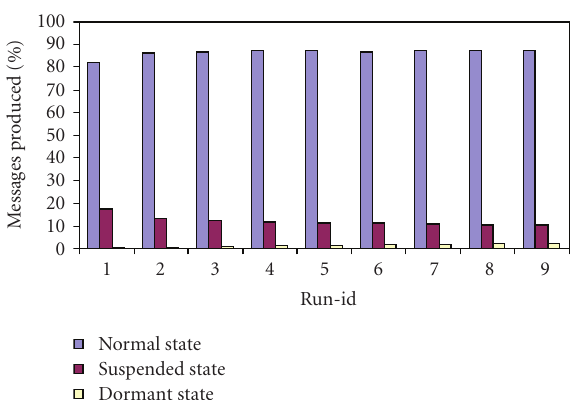
Figure 7: Messages produced for each run by nodes in di ff erent status.